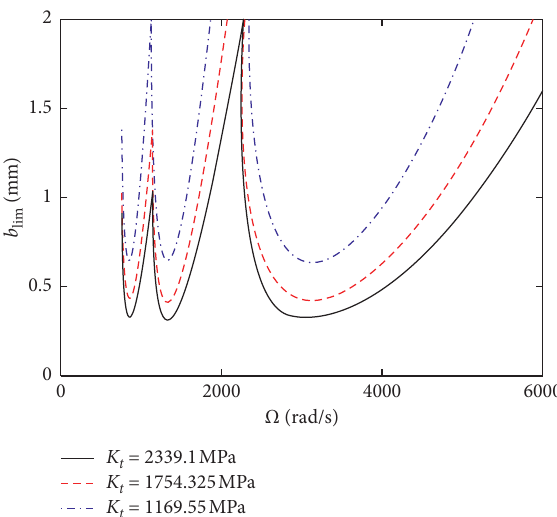
Figure 8: Effect of the cutting force